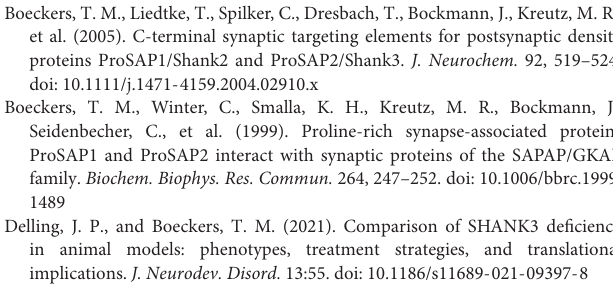
in white. (A) Rock-GS, (B) SY-311, (C) SY-302, (D) SY-304, (E) ASC, (F) CS, (G) Fr1 + 2, (H) Fr1 + 2 + 3, and (I) vNterm. Scale bar 20 µ m. Left graph: Total intensity of the SHANK3 puncta. SHANK3 puncta co-localizing with the respective pre-synaptic marker (red) or not co-localizing (blue) are shown. Right graph: Average intensity of the SHANK3 puncta. The boxplot shows the median and the interquartile range, the whiskers cover minimal to maximal values. The white dot marks the mean. Data collected from a total of 40 cells of 4 independent experiments. Groups were tested for normality using the Shapiro-Wilk-Test and then compared using the Wilcoxon test. ∗∗ p ≤ 0.01, ∗∗∗ p ≤ 0.001, ∗∗∗∗ p ≤ 0.0001. Supplementary Figure 2 | Continued IHC analysis in striatum of mouse brain sections. Sections of WT [ Shank3( + / + )] and KO [ Shank3 (cid:49) ex11(–/–) ] mice were analyzed. Sections were stained against SYNAPSIN1/2 or BASSOON and SHANK3. (A) Rock-GS, (B) SY-311, (C) SY-302, (D) SY-304, (E) ASC, (F) CS, (G) Fr1 + 2, (H) Fr1 + 2 + 3, and (I) vNterm. Left graph: Total intensity of SHANK3 puncta co-localizing with the respective pre-synaptic marker (red) or not co-localizing (blue) are shown. Right graph: Size of SHANK3 puncta. The boxplot shows the median and the interquartile range, the whiskers cover minimal to maximal values. n = 3 animals per genotype. One-way ANOVA. G: genotype. C: co-localization or not. G:C: correlation of genotype and co-localization. ∗ p ≤ 0.05. Supplementary Figure 3 | Continued IHC analysis in cortex of mouse brain sections. Sections of WT [ Shank3( + / + ) ] and KO [ Shank3 (cid:49) ex11(–/–) ] mice were analyzed. Sections were stained against SYNAPSIN1/2 or BASSOON and SHANK3. (A) Rock-GS, (B) SY-311, (C) SY-302, (D) SY-304, (E) ASC, (F) CS, (G) Fr1 + 2, (H) Fr1 + 2 + 3, and (I) vNterm. Left graph: Total intensity of SHANK3 puncta co-localizing with the respective pre-synaptic marker (red) or not co-localizing (blue) are shown. Right graph: Size of SHANK3 puncta. The boxplot shows the median and the interquartile range, the whiskers cover minimal to maximal values. n = 3 animals per genotype. One-way ANOVA. G: genotype. C: co-localization or not. G:C: correlation of genotype and co-localization. ∗ p ≤